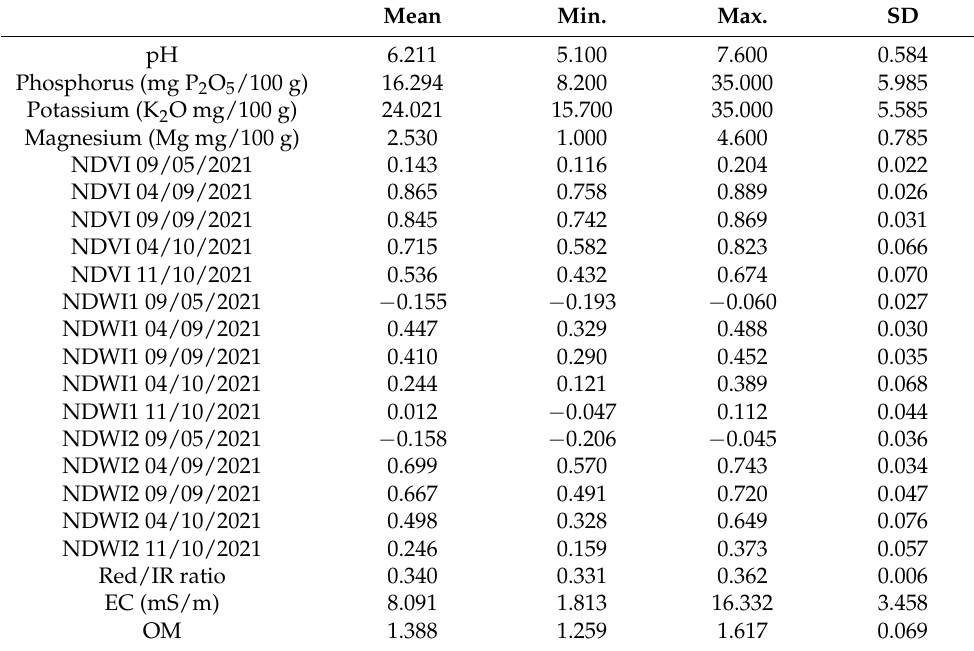
Table 1. Basic statistical parameters for variables used in the study. Mean